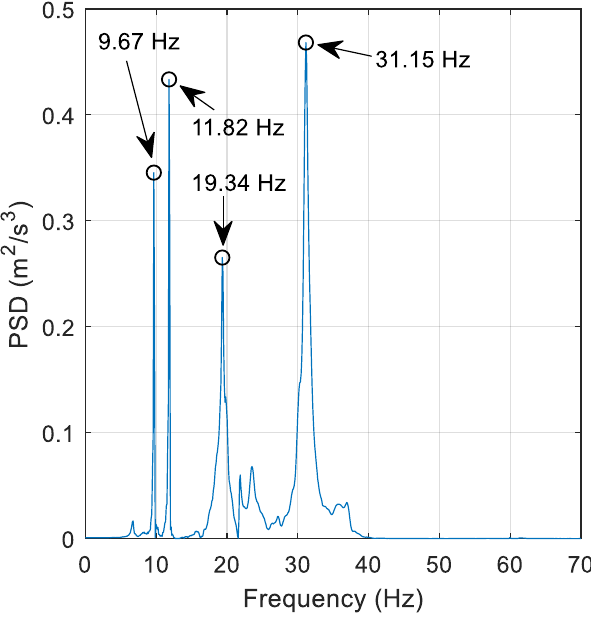
Figure 13. PSD of free-vibration acceleration data.